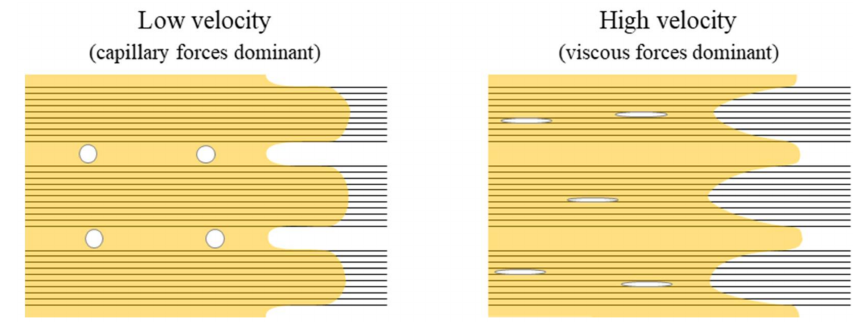
Figure 1. Illustration of impregnation mechanisms inducing void formation at the flow front.